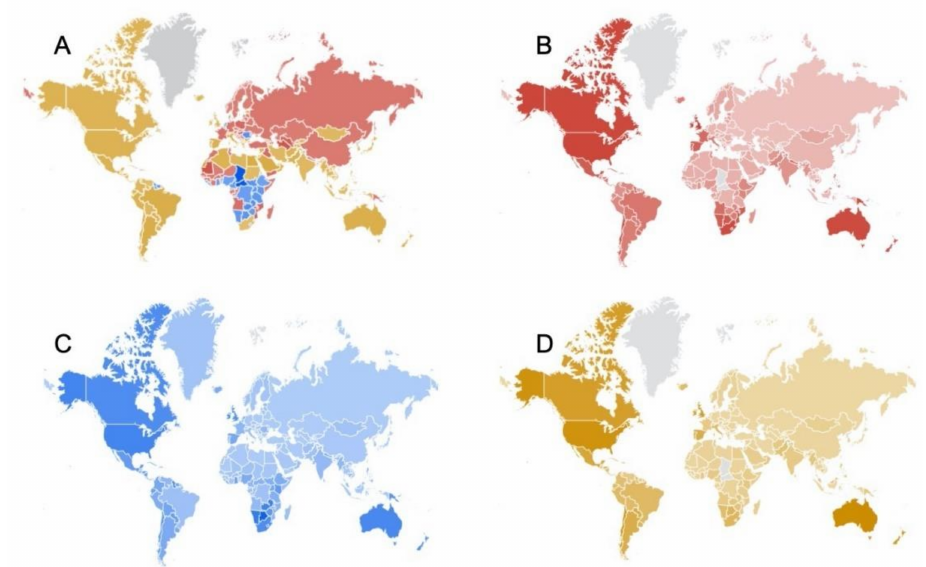
Figure 1. World distribution of relative search volumes (RSVs) from 2010–2020, and related to: ( A ) all terms (obesity, alcohol, and smoking); ( B ) smoking terms (red); ( C ) alcohol terms (blue); and ( D ) obesity terms (yellow). Greater shading indicates RSVs (the figure was captured from Google Trends; Data source: Google Trends (https://www.google.com/trends, accessed on 20 September 2020).